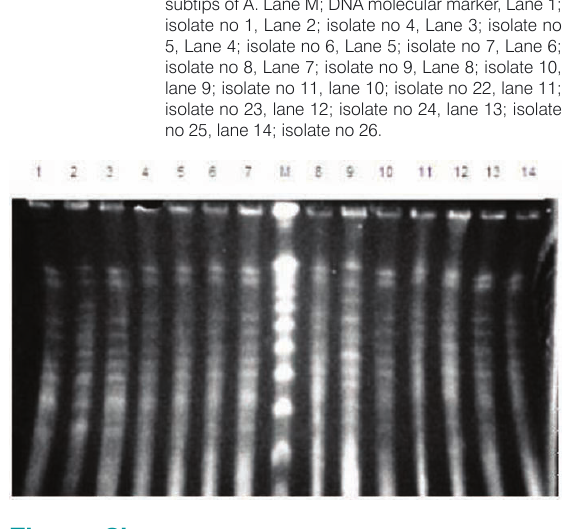
Figure 2b. Pulsed field gel electrophoresis patterns of the other strains. Lane M; DNA molecular marker, Lane 15; isolate no 3, Lane 16; isolate no 12, Lane 17; isolate no 13, Lane 18; isolate no 17, Lane 19; isolate no 18, Lane 20; isolate no 19, Lane 21; isolate no 20, Lane 22; isolate no 21, Lane 23; isolate no 27, Lane 24; isolate no 28, Lane 25; isolate no 16.